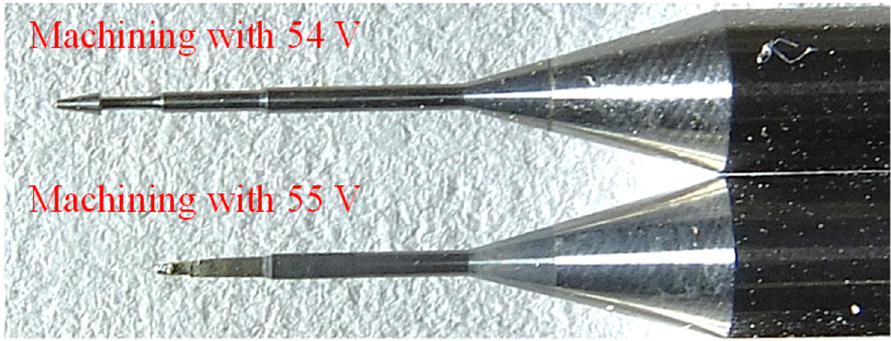
Figure 13. Thermal image taken during combinational assisted machining.